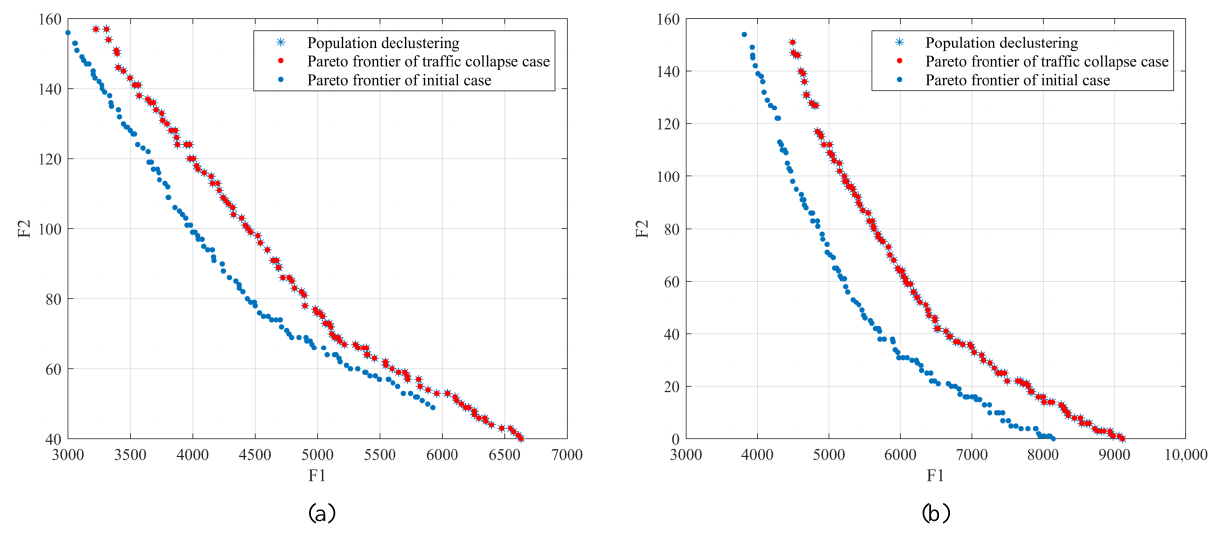
Figure 8. Population scatter comparison of the secondary disaster in period ( a ) T 1 and ( b ) T 2